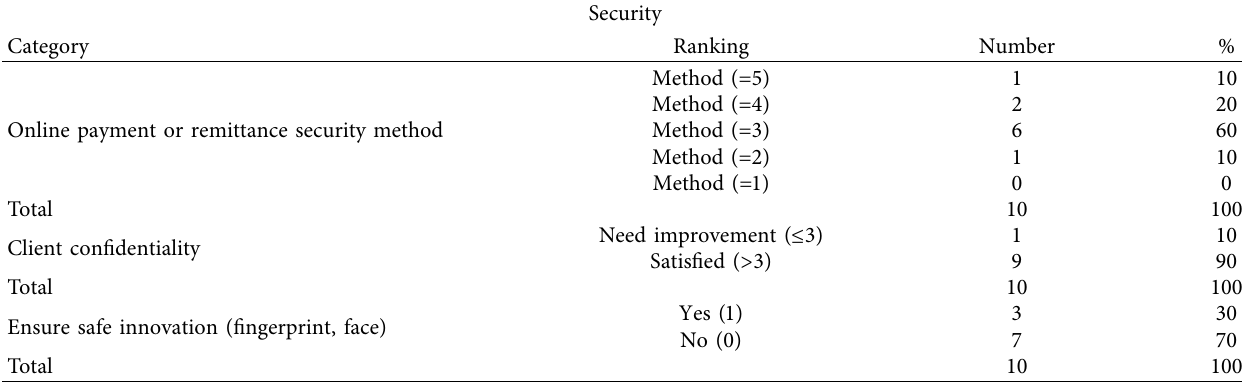
Table 7: Summary of security.